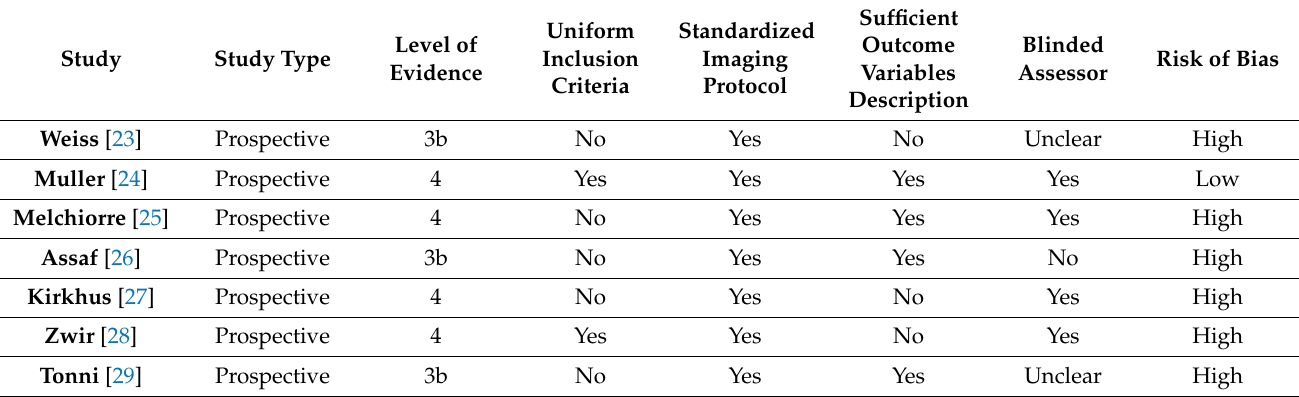
Table 2. The quality assessment of included studies.